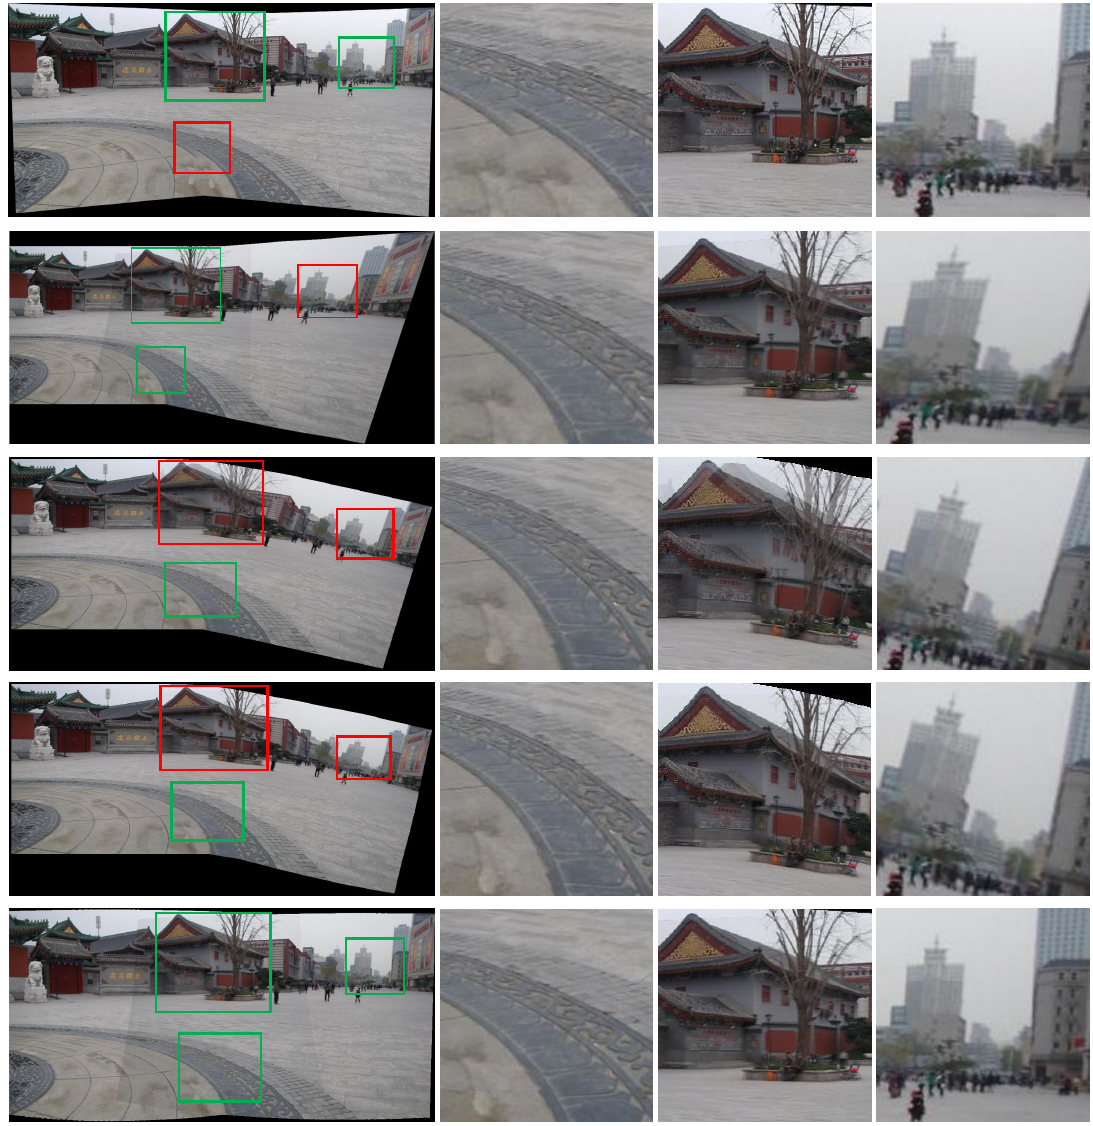
Figure 5. Comparison with the other image stitching algorithms on Temple images. From first row to last row, the results are: ICE, APAP, SPHP, SPHP+APAP, and our